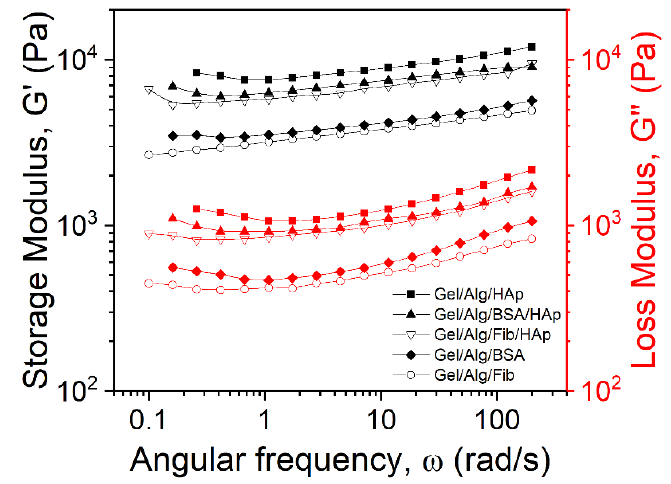
Figure 7. Oscillatory frequency sweep.